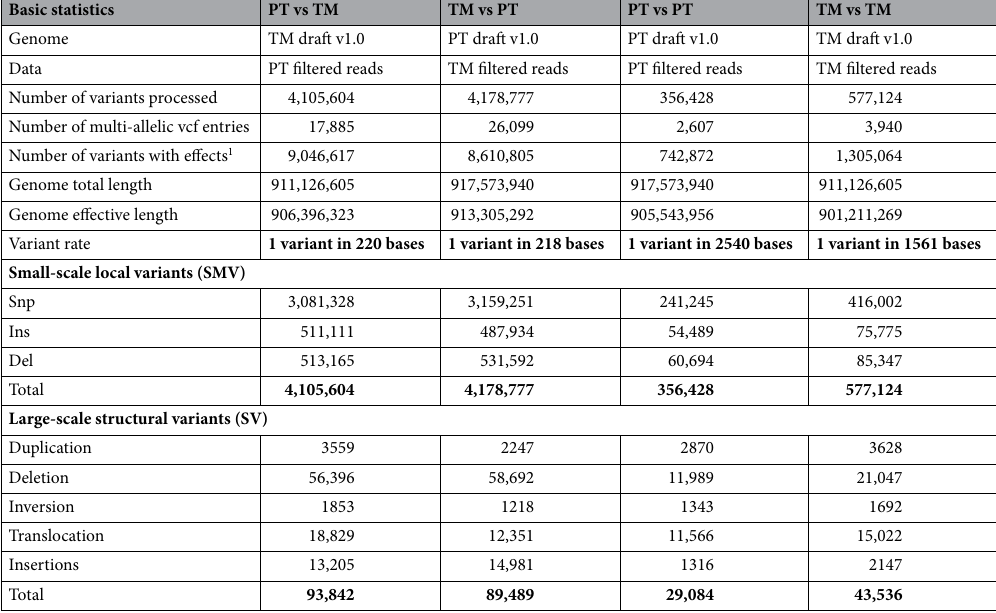
Table 8. Overview on inter- and intraspecies variant analysis result: The numbers represent heterogeneity between species (for PT vs TM and TM vs PT) and heterogeneity within species (for PT vs PT and TM vs TM). These numbers may include the net effect of technical issues (e.g., with assembly, annotation, mapping and calling algorithms). 1 as determined by SNPeff 37